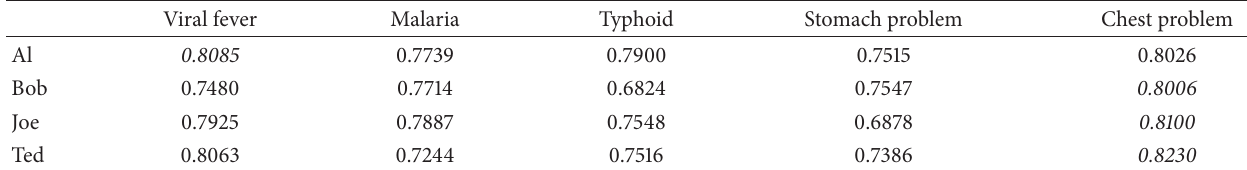
Table 5: Values of 𝜌 for each patient to the considered set of possible diagnoses. DHFS 3 Viral